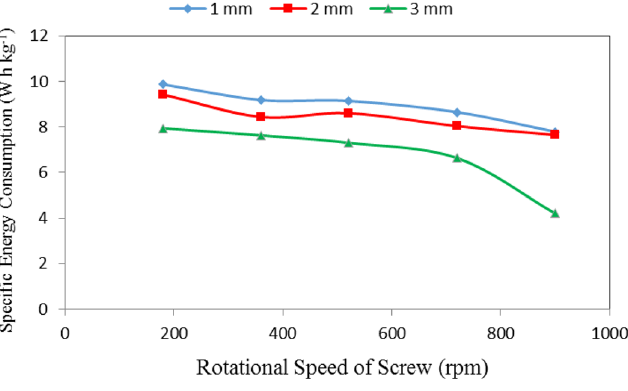
Figure 10. Specific energy consumption at different feed pellet sizes and rotational speeds of screw.